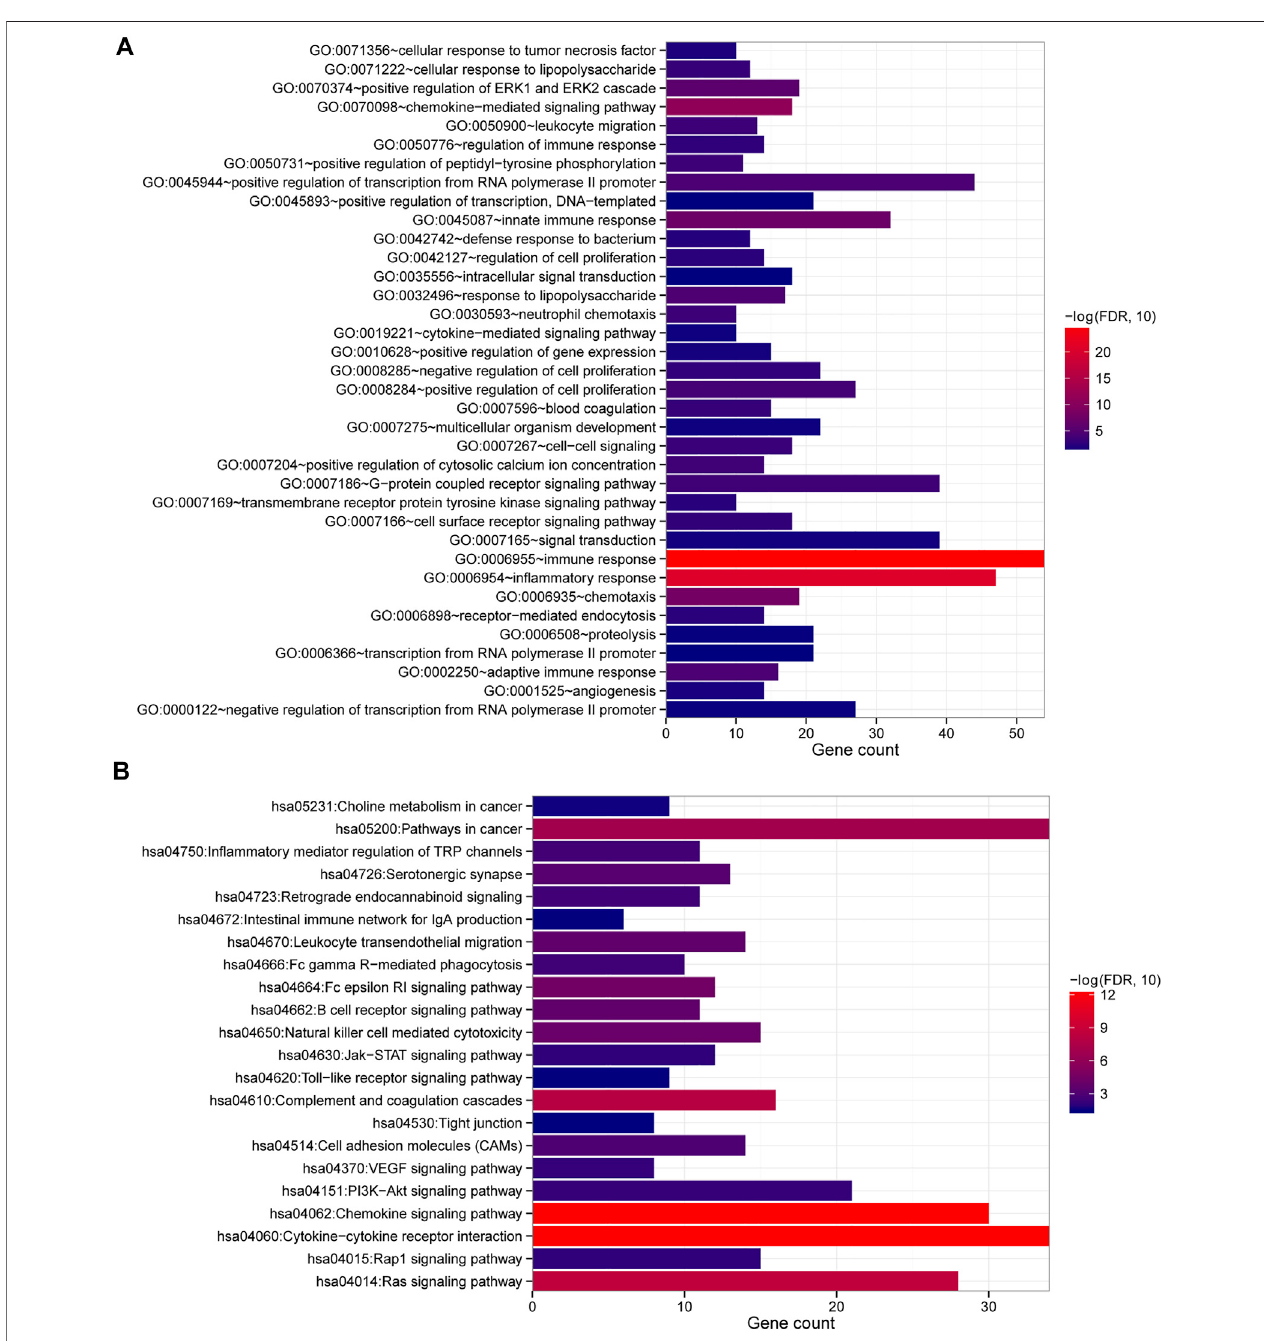
FIGURE 2| GO and KEGG analysis of DEGs. (A) Enriched GO terms with p values < 0.05. (B) KEGG pathwayswere enriched with a p value of < 0.05. The number ofDEGswasrepresentedbythehorizontalaxis,andtheGOorKEGGitemswererepresentedbytheverticalaxis:thegreaterthesigni fi cance,thecloserthecolumncolor is to